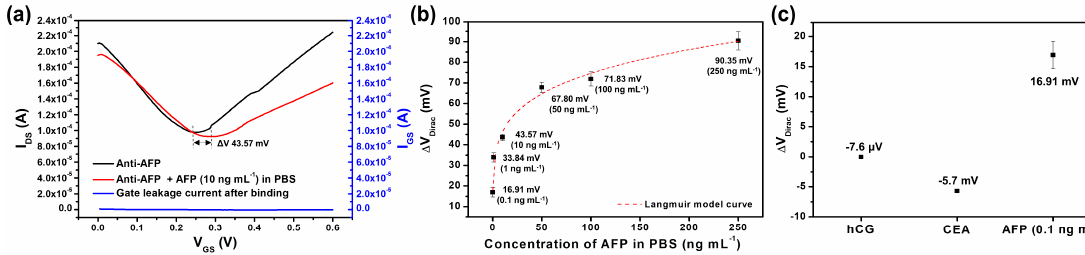
Figure 4. ( a ) the I DS -V GS characteristics of G-FET before and after binding to AFP (10 ng mL − 1 in PBS) on the anti-AFP-immobilized channel surface; ( b ) sensitivity of the anti-AFP-immobilized G-FET for AFP detection in PBS; ( c ) selectivity of the anti-AFP-immobilized G-FET for AFP compared with hCG and CEA.